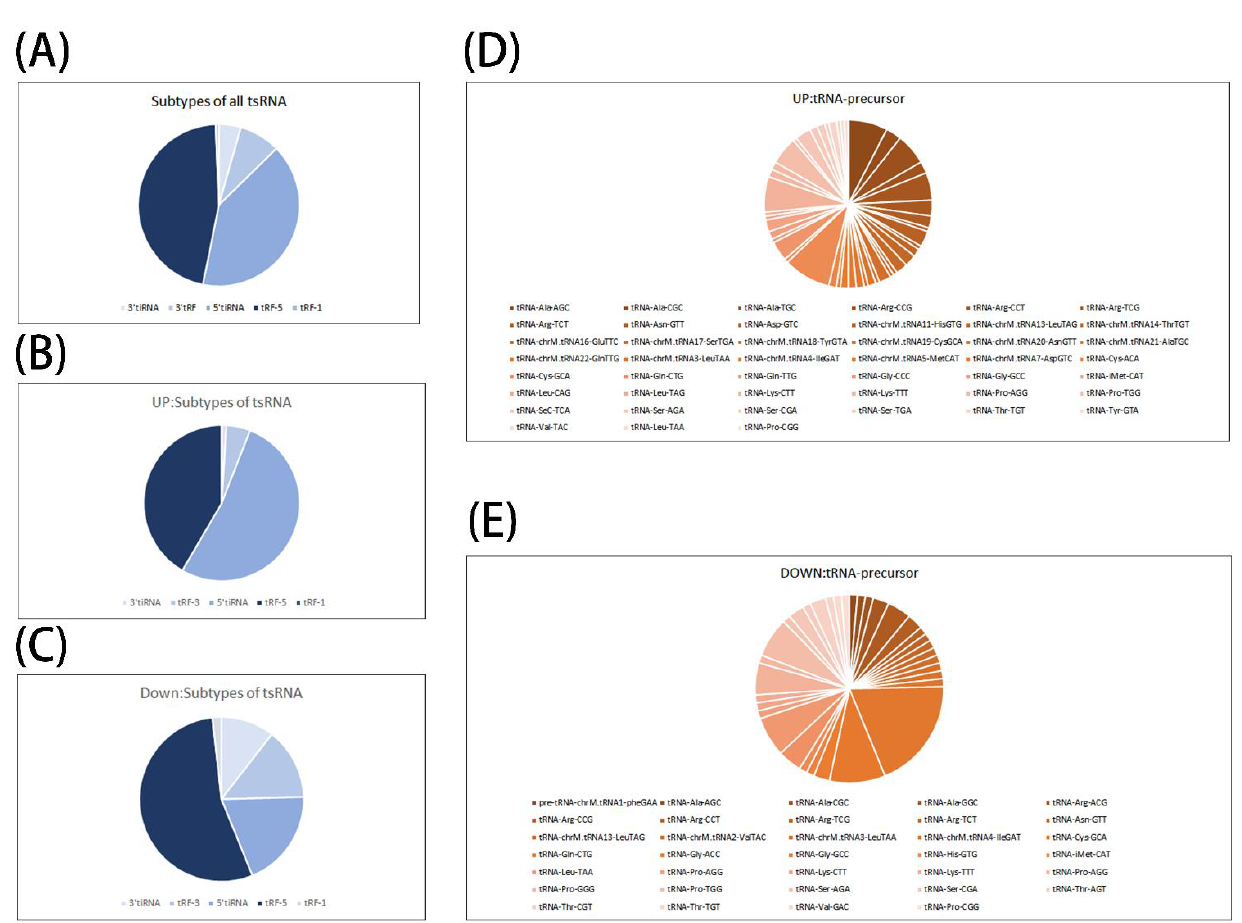
Figure 2. Preliminary analysis of microarray results. ( A – C ) Pie chart of the distribution of tiRNA and tRF subtypes. The color represents the tiRNA and tRF subtypes. ( D , E ) Pie chart of the distribution of tsRNA-precursors. The color represents the tsRNA-precursors. tRF: tRNA fragments; tiRNA: tRNA halves; tsRNA: tRNA-derived small RNA.